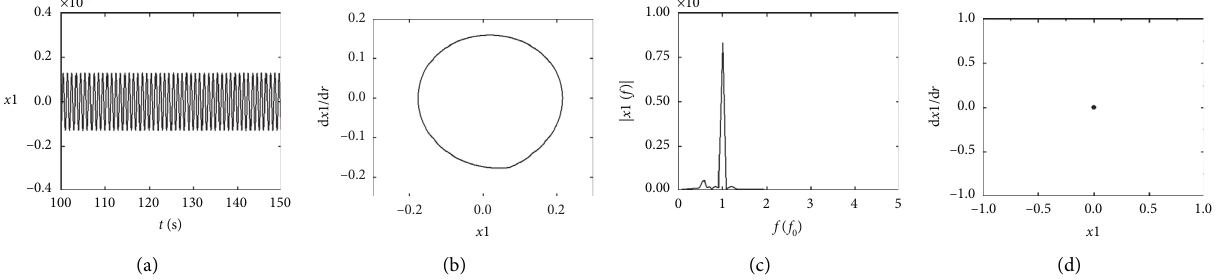
� 5 k ′ . (a) Time domain waveform, (b) phase trajectory, (c) frequency spectrum, 2 2